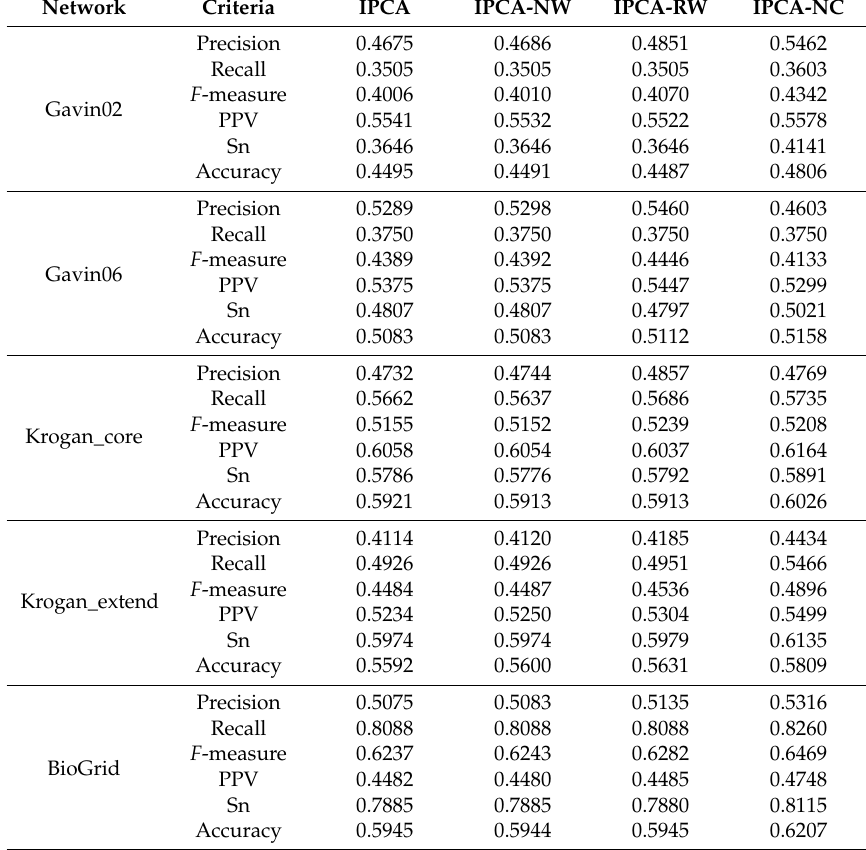
Table 3. Comparison results of IPCA algorithm with new node weighing method (IPCA-NW), IPCA algorithm with roulette wheel method (IPCA-RW) and (IPCA algorithm with NC metric (IPCA-NC) in Equation (8)) with original